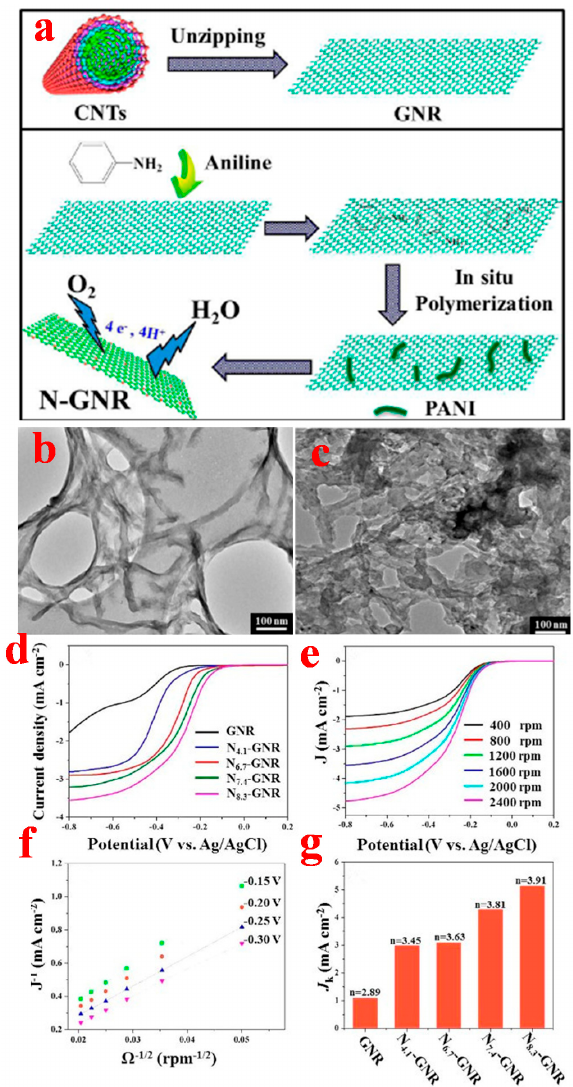
Figure 7. ( a ) Schematic charts for the synthesis of N ‐ GNRs (nitrogen ‐ doped graphene nanoribbons); TEM images of ( b ) pure GNRs sheets and ( c ) GNR/PANI composites; ( d ) LSV curves of GNRs and N ‐ GNRs in O 2 ‐ saturated 0.1 M KOH solution (1600 rpm); ( e ) LSV curves for N 8.3 ‐ GNRs with different rotating speeds; ( f ) K ‐ L plots of GNRs and N ‐ GNRs from LSVs; ( g ) kinetic ‐ limiting current density at 0.7 V of GNRs and N ‐ GNRs. Reprinted with permission from [110]. Copyright 2014, American Chemical Society.